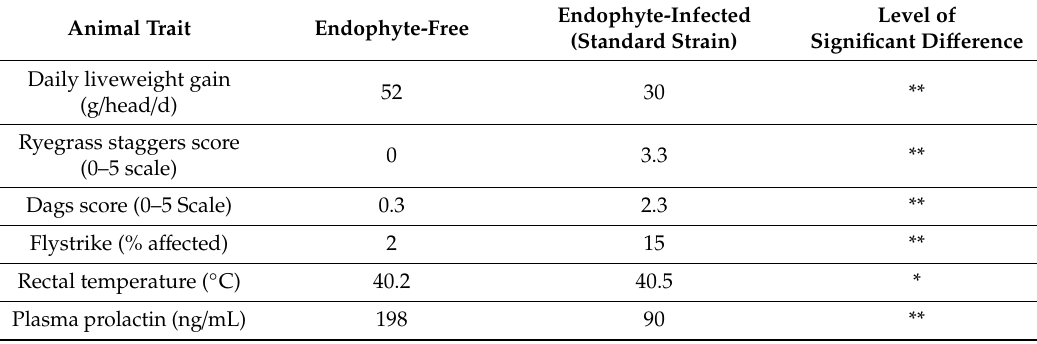
Table 3. The productivity and health of young sheep (30 per treatment) grazing either endophyte-free or endophyte-infected perennial ryegrass during summer and autumn periods between 1992 and 1995 on unirrigated pasture in Canterbury, New Zealand. (Taken from